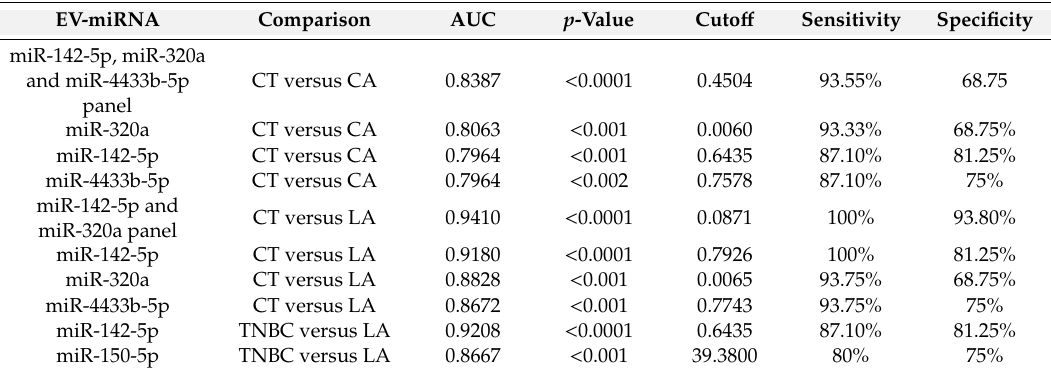
Figure 5. Individual receiver operating characteristic (ROC) curves from EV-miRNAs tested by RT-qPCR. ( A ) BC diagnosis accuracy calculated for miR-142-5p, ( B ) miR-320a, and ( C ) miR-4433b-5p. ( D ) Accuracy to diagnose Luminal A (LA) patients over Controls (CT) using miR-142-5p, ( E ) miR-320a, and ( F ) miR-4433b-5p. ( G ) Capacity to discriminate LA over Triple-negative (TNBC) patients using miR-142-5p and ( H ) miR-150-5p. ROC curves calculated based on relative quantification (RQ) values. Only area under the curve (AUC) > 0.79 are shown. Table 4. Diagnostic potential of the four EV-miRNAs, individually and combined, based on the ROC curve